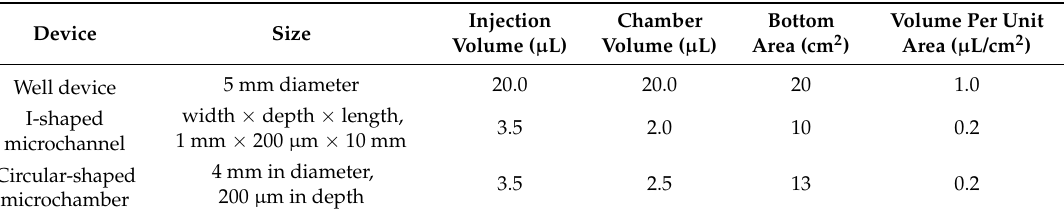
Figure 1. Effect of microchannel shape for detection of mitochondrial DNA. ( a ) Well for control experiments. ( b ) I-shaped microchannel device. ( c ) Circular-shaped microchamber device. Rolling circle amplification products (RCPs) from mitochondrial DNA in HeLa cells are visible in red; cell nuclei are in blue. The 2993-bp fragment was amplified using the padlock probe ppMSCs. ( d ) Numbers of detected RCPs per cell were digitally counted with ImageJ software. Data are shown as mean ± standard deviation (SD) of 15 images. * p < 0.05 (unpaired two-tailed Student’s t test). Table 2. Volume and Bottom area of device.